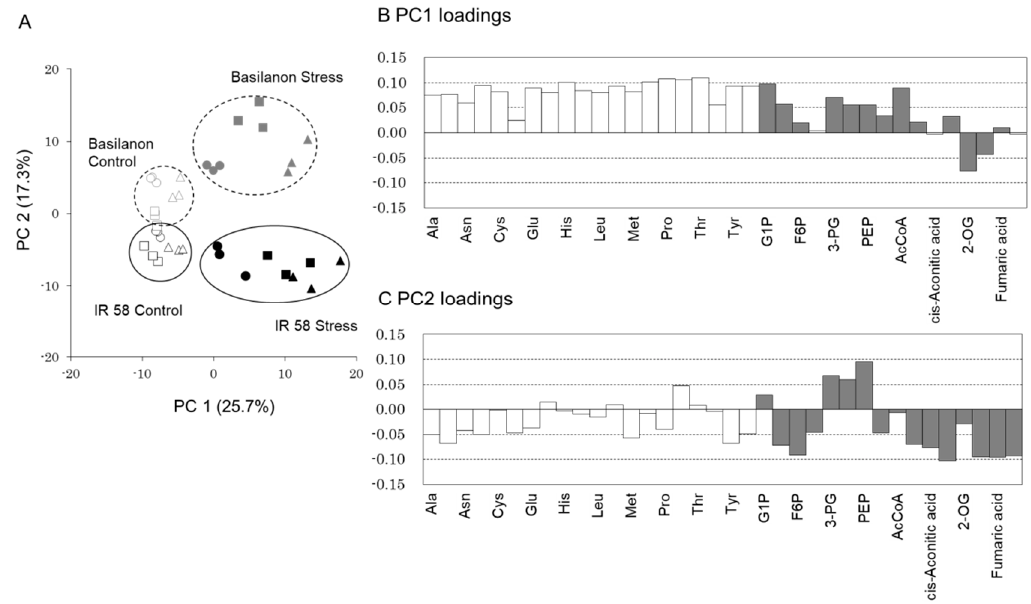
Figure 2. Principal component analysis (PCA) on 276 metabolites. ( A ) PCA scores are presented based on a combination of two components (PC1 and PC2). Circles, triangles, and squares indicate 1, 3, and 7 days (24, 72 and 168 h) after treatment, respectively. ( B , C ) Loadings of amino acid (white) and metabolites in glycolysis and citric acid cycle pathways (gray).